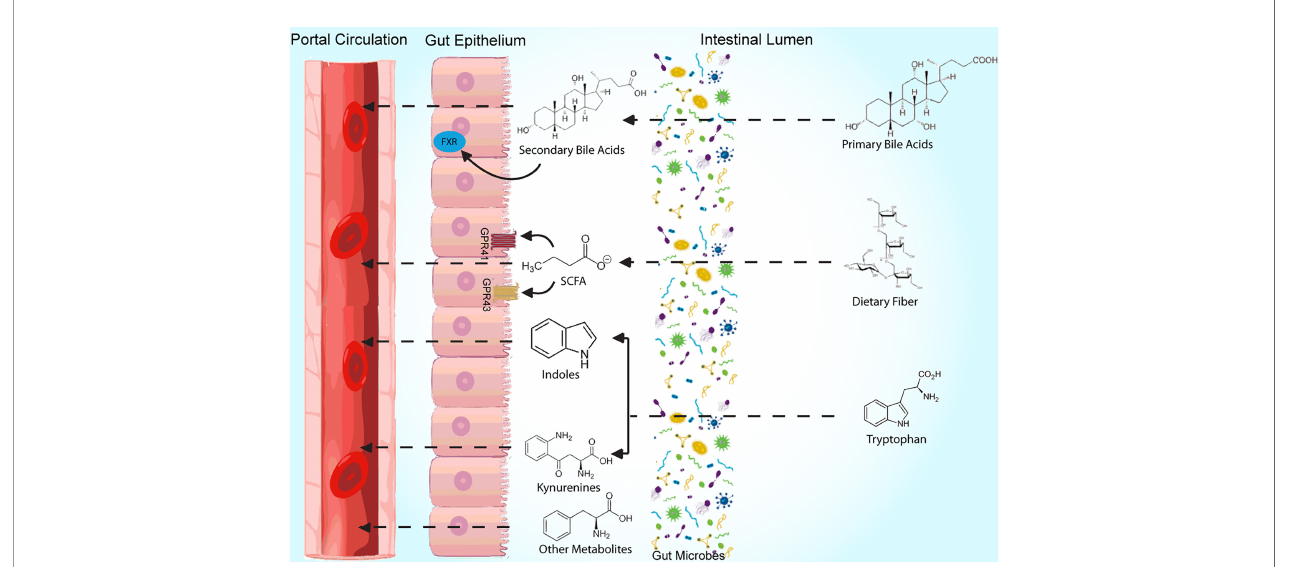
FIGURE 1 | Summary diagram of bacterial metabolites and some of their mechanisms of